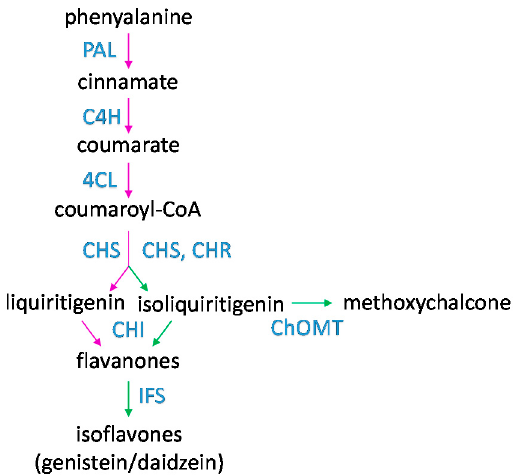
Figure 1. The isoflavonoid biosynthesis pathway. PAL (Phenylalanine ammonia-lyase), C4H (Cinnamate 4-hydroxylase), 4CL (4-coumarate CoA-ligase), CHS (Chalcone synthase), CHR (Chalcone reductase), CHI (Chalcone isomerase), IFS (Isoflavone synthase), ChOMT (Chalcone O-methyltransferase). Legume specific steps are indicated in green.